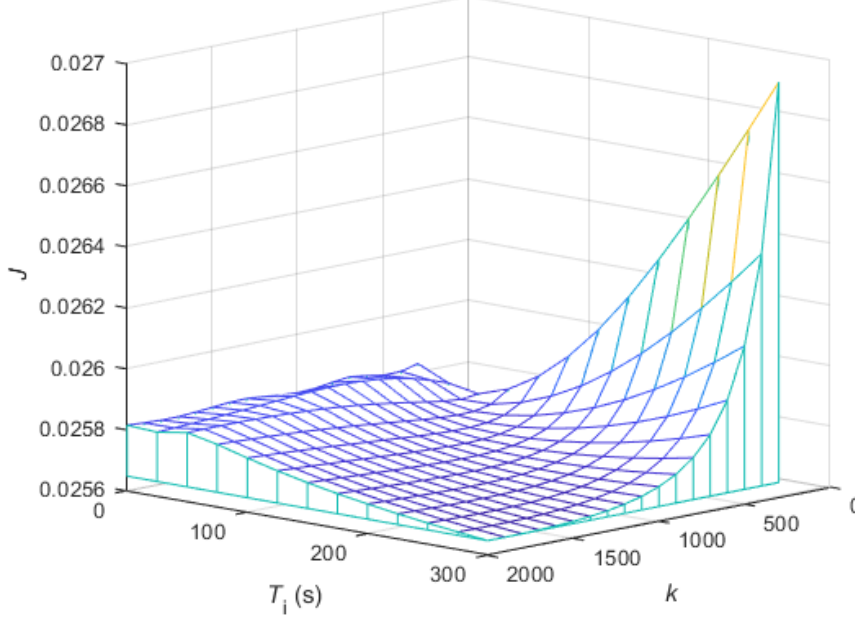
Figure 7. Three-dimensional graph showing the dependence of the objective function J on the gain k and time constant T i of the PI-controller. and time constant T i of the